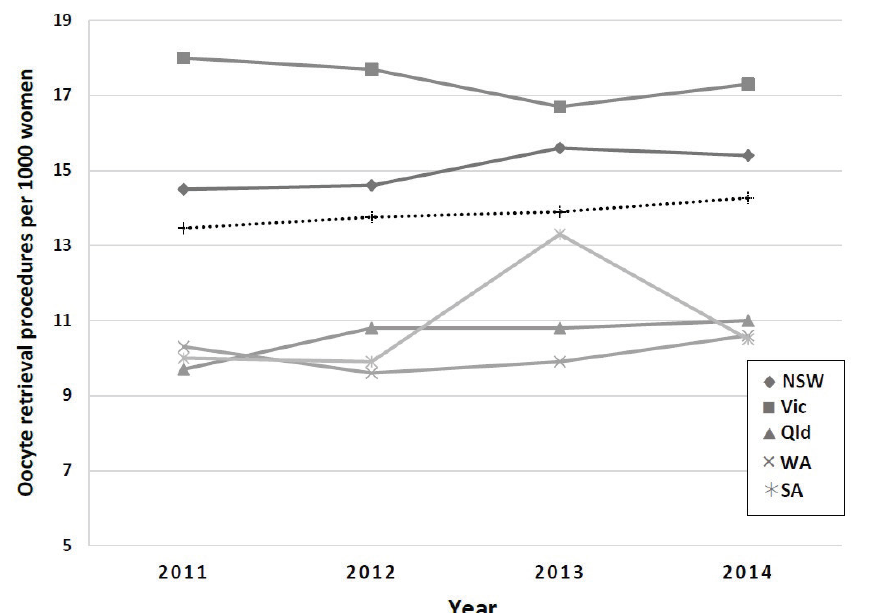
[NSW – New South Wales, Vic – Victoria, Qld – Queensland, WA – Western Australia, SA – South Australia. Overall national incidence rate for Australia as black dashed line] Figure 2. Age-stratified incidence rate of in vitro fertilisation (IVF) cycles proceeding to oocyte retrieval in women aged 35 to 44 years in Australia (oocyte retrieval procedures per 1000 women per year), 2011 to 2014 inclusive